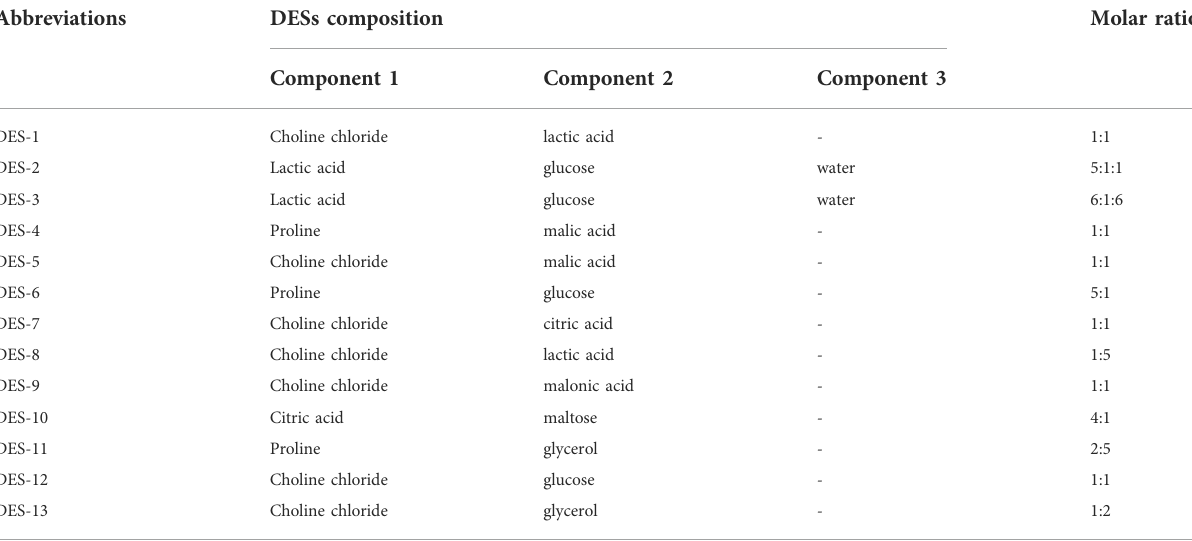
TABLE 1 The composition of the studied DESs and their abbreviation in this